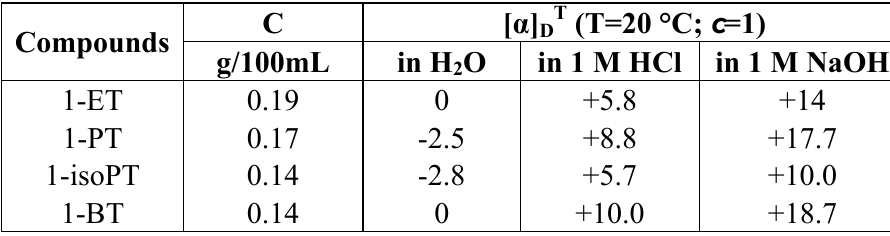
Table 1. Concentration (C, in g/100 mL), specific rotation [ α ] DT for 1-alkyl-tryptophan analogs at 589 nm at temperature T and concentration c (in g/100 mL; at 20